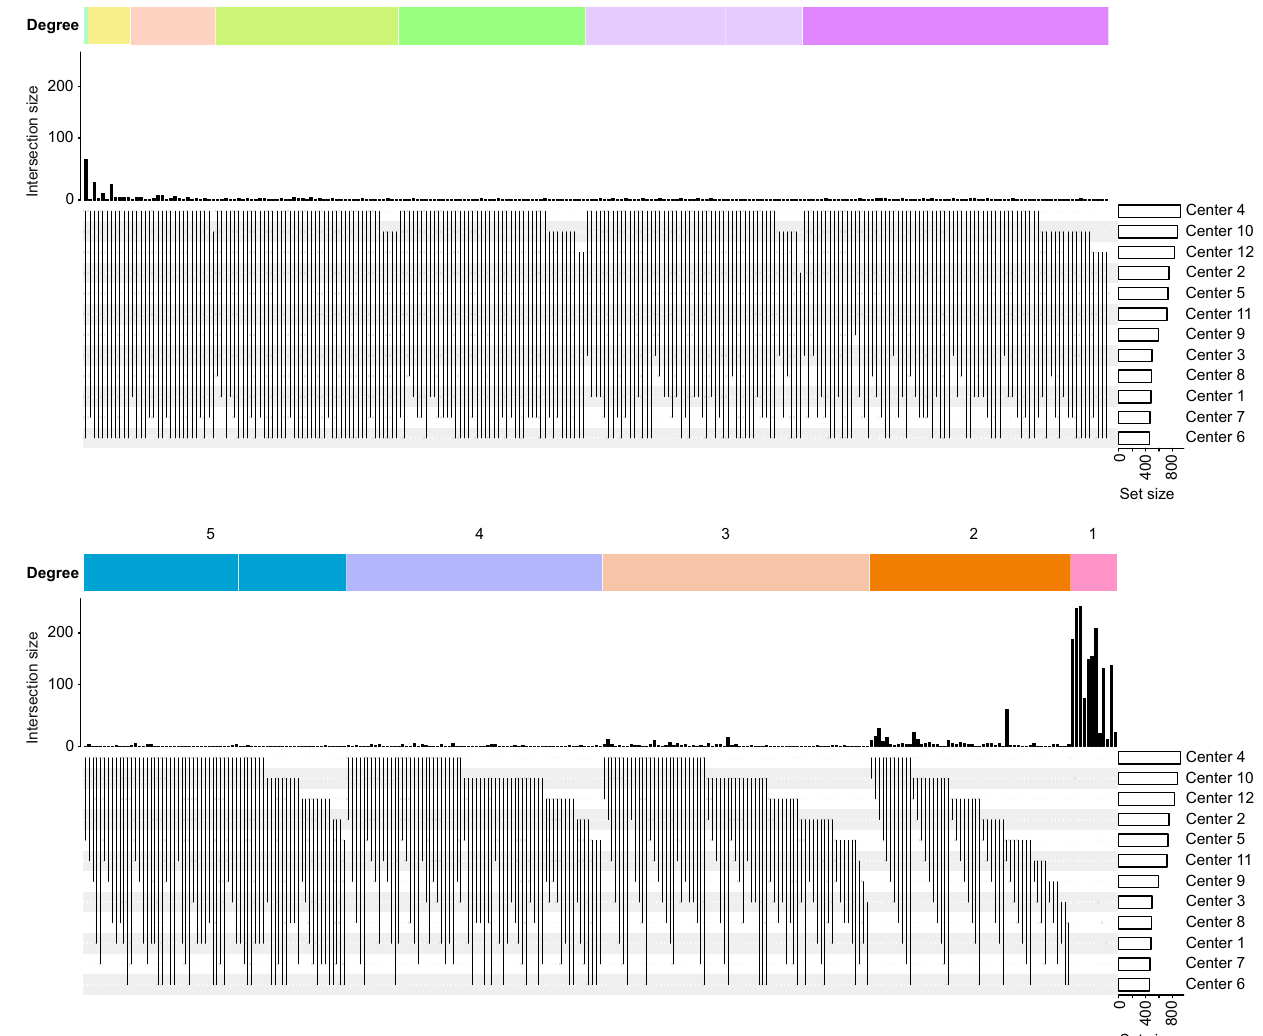
Fig.5|Uniquenessofthedataobtainedfromthe12differentcorefacilities. Upsetplotshowingthelargevariabilitiesinthenumberofdetectedproteinswithinthedata provided by 12